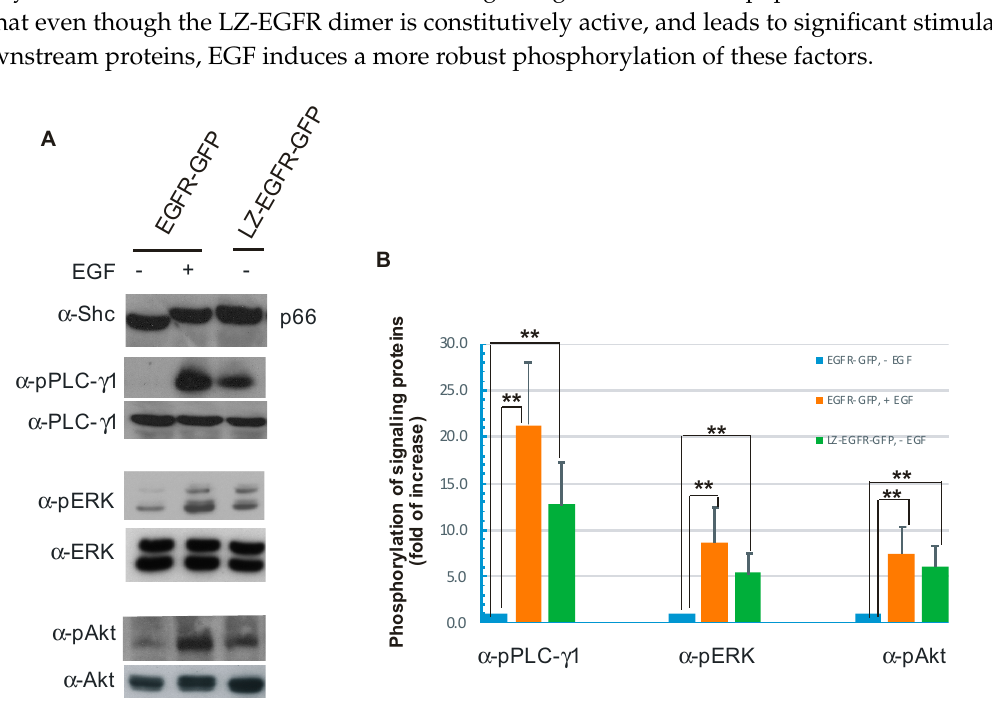
Figure 7. Stimulation of various signal transduction pathways by activation of EGFR-GFP or LZ-EGFR-GFP. ( A ) 293T cells were transiently transfected with EGFR-GFP or LZ-EGFR-GFP. Following serum starvation for 24 h, cells were treated with or without EGF. The cell lysates were subjected to immunoblotting analysis with rabbit anti-SHC, rabbit anti-phospho-PLC- γ 1, rabbit anti-PLC- γ 1, mouse anti-phospho-ERK1/2, mouse anti-Erk1/2, rabbit anti-phospho-Akt and rabbit anti-Akt antibodies; ( B ) Quantification of the data from ( A ). The band is quantitated by densitometry with image J software. The protein phosphorylation level of the control (EGFR-GFP, without EGF treatment) was set to 1 and the phosphorylation of the proteins under other conditions was expressed as the fold increase compared to control. Each value is the average of at least three independent experiments and the error bar is the standard error. **: p < 0.01.